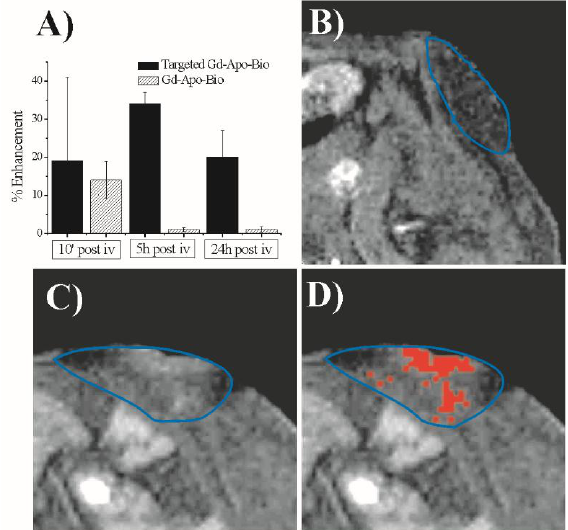
Figure 5. ( A ) MRI signal intensity (SI) enhancement of tumors in SCID mice grafted with TECs treated